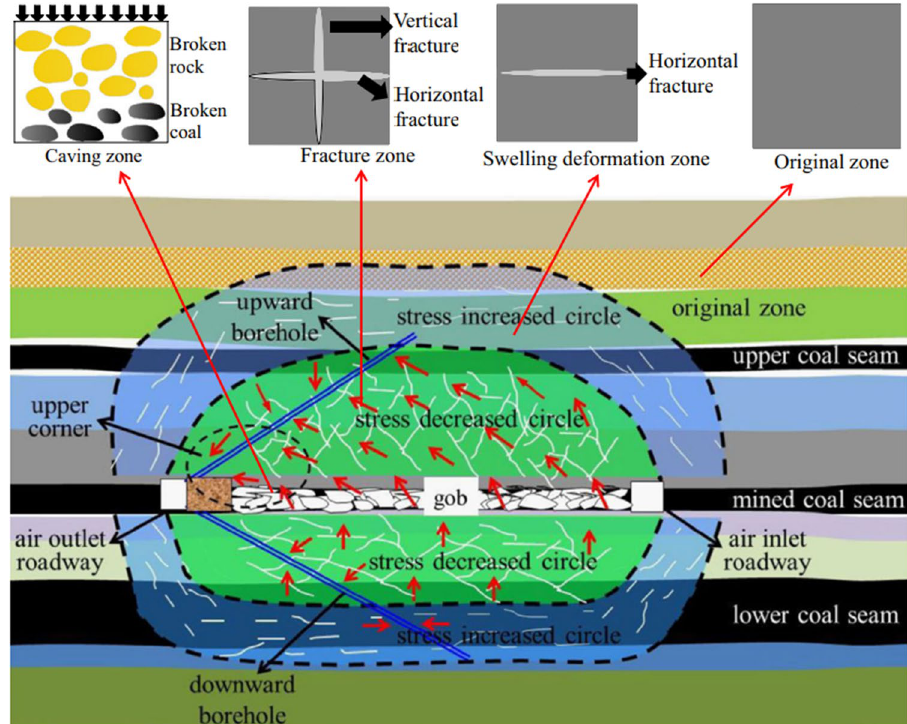
Fig. 1 Different damage zones in pressure relief mining (PRM), modified after (Zhang et al. 2019a, b, c, d, e, f; Zhang et al. 2020a, b, c,